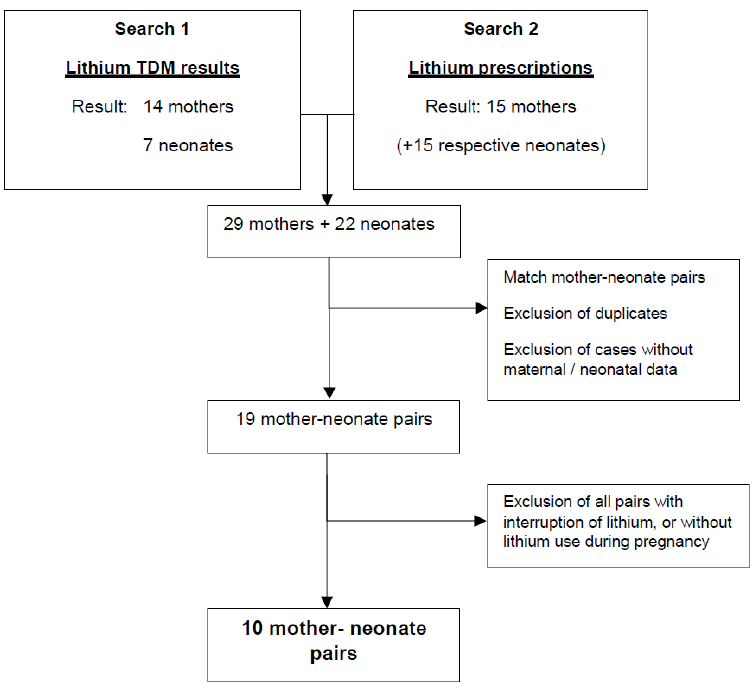
Figure 1. Flowchart presenting the recruitment of the mother-neonate pairs. Maternal characteristics at delivery are presented in Table 1. The maternal diagnosis for each case was bipolar disorder ( n = 10). Median maternal TDM at delivery was 0.62 mmol/L (IQR 0.54 – 0.72 mmol/L). Besides hypertension ( n = 1) and intrahepatic cholestasis of pregnancy ( n = 1) as pregnancy complications, 4 cases suffering from gestational diabetes mellitus (2 of them insulin-dependent) were defined. The use of concomitant medication was present in 9/10 cases. The most frequently used medicine was levothyroxine ( n = 7). One mother was co-treated with an anti-epileptic drug (lamotrigine), and 6 mothers with antipsychotic medication (1 conventional antipsychotic: haloperidol ( n = 1), 3 atypical antipsychotics: quetiapine ( n = 3), olanzapine ( n = 2) and aripiprazole ( n = 1)), and 1 mother with the benzodiazepine lorazepam during their pregnancy (Table 1).